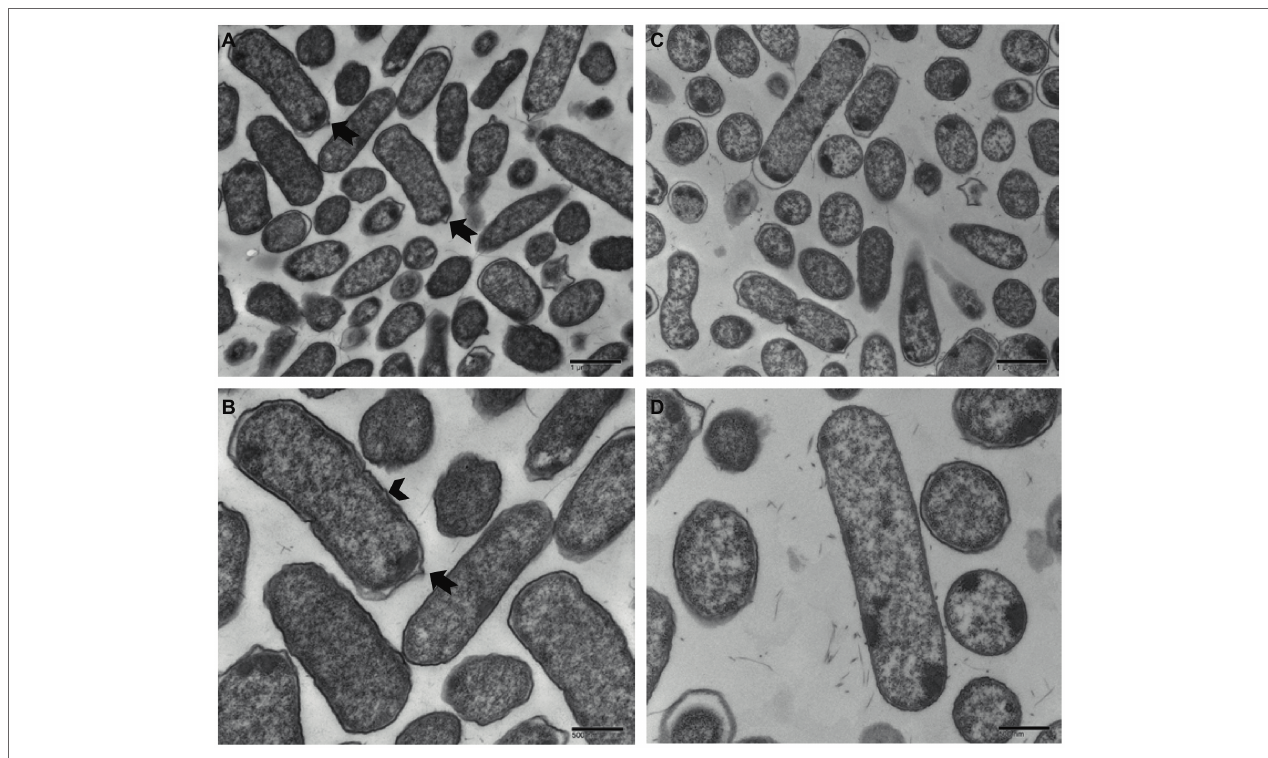
FIGURE 7 | Transmission electron micrographs of Salmonella Typhimurium ATCC 14028 rugose morphotype cells at different magnifications (A,B) and smooth morphotype cells at different magnifications (C,D) . Notched arrow indicates membrane vesicle formation and arrowhead indicate rough and thick cell